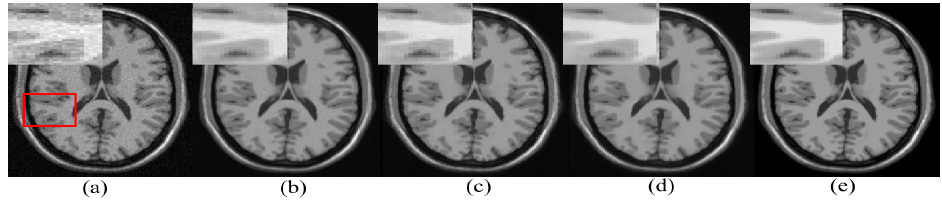
Figure 7. Illustration of the significance of the proposed categorization of smooth and textured/edge patches and progressive estimation of eigenvectors by adapting it with the existing low-rank ap- proximation (LRA)-based denoised approach [15]. ( a ) Noisy image (3% Rician Noise), ( b ) denoised using the existing LRA-based denoising approach [15], ( c ) the proposed denoising approach, ( d ) the existing approach [15] adapted with the proposed patch categorization and re-estimation of eigenvectors, ( e ) noise-free